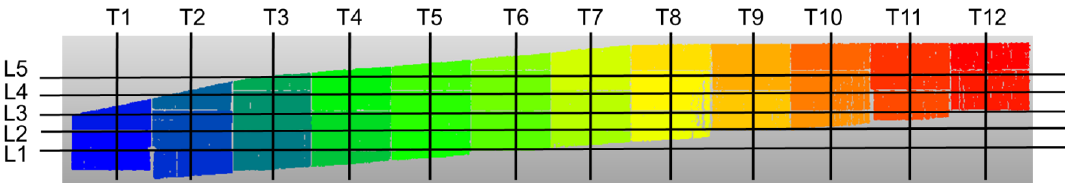
Figure 17. Longitudinal and transversal lines used to define the angular distortions for a planar face of the MSE wall at Site-1.